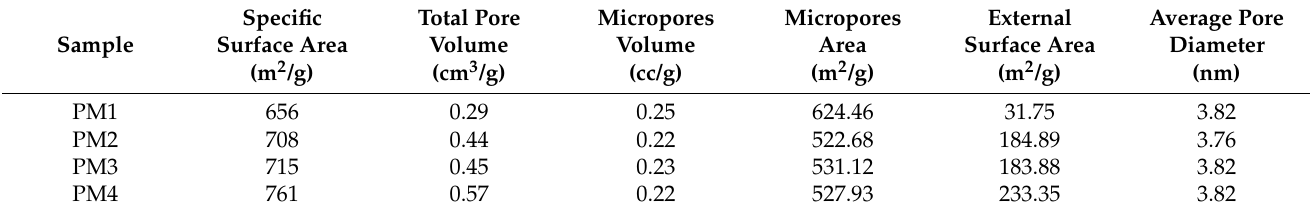
Figure 5. Pore size distribution of magnetic nanocomposites. Table 3 summarizes the characteristics of the porous structure of magnetic nanocomposites. Table 3. Characteristics of the magnetic